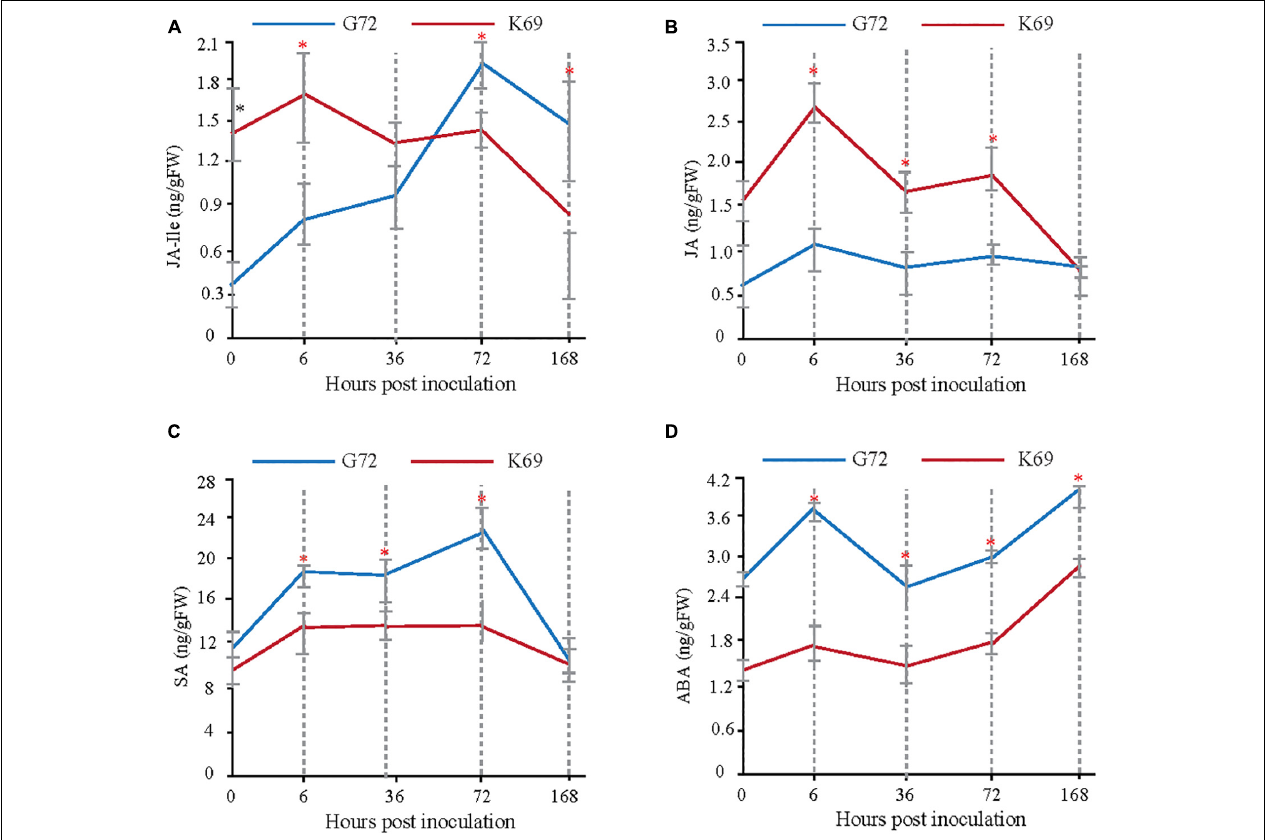
FIGURE 2 | Measure and comparison of phytohormones levels between the K69 and G72 lines during powdery mildew infection. * Indicates significant difference ( P < 0.05, according to